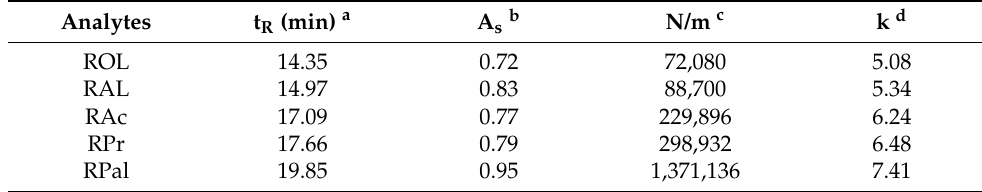
Table 4. System suitability test for a standard solution of 10 µ g mL − 1 applying the proposed method.